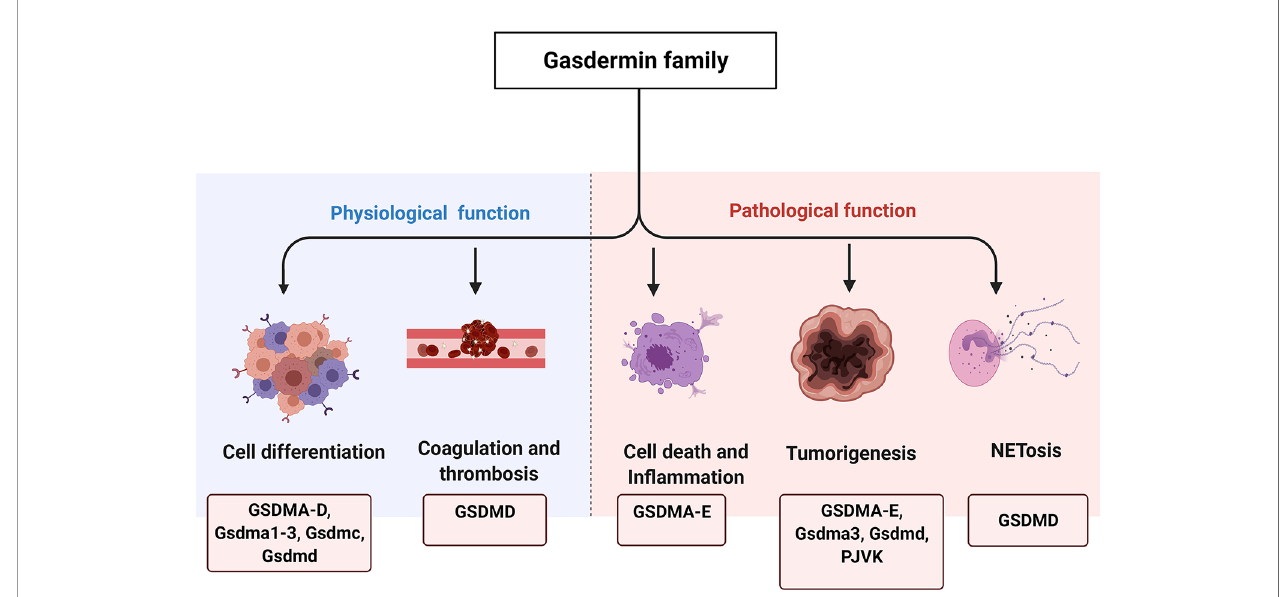
FIGURE 1 | The physiological and pathological functions of GSDM family. GSDM family members are involved in various physiological and pathological processes, such as cell differentiation, coagulation and thrombosis, cell death and in fl ammation, tumorigenesis as well as